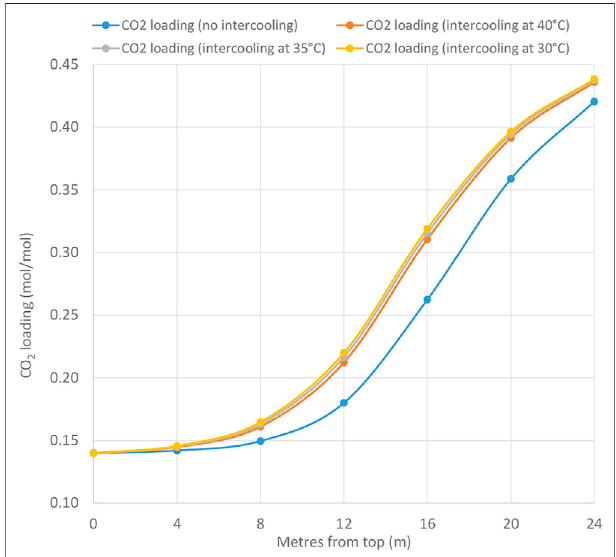
FIGURE 13 | Increase in CO 2 loading along the absorber for 24 m packing height, capture level of 99% and lean loading of 0.14 molCO 2 /